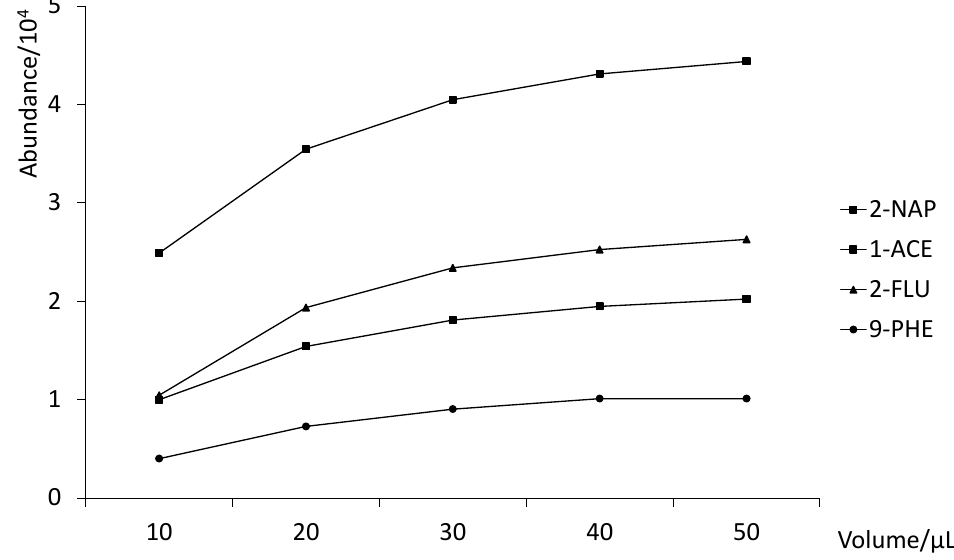
Figure 3. Optimization of MEPS elution solvent volume.